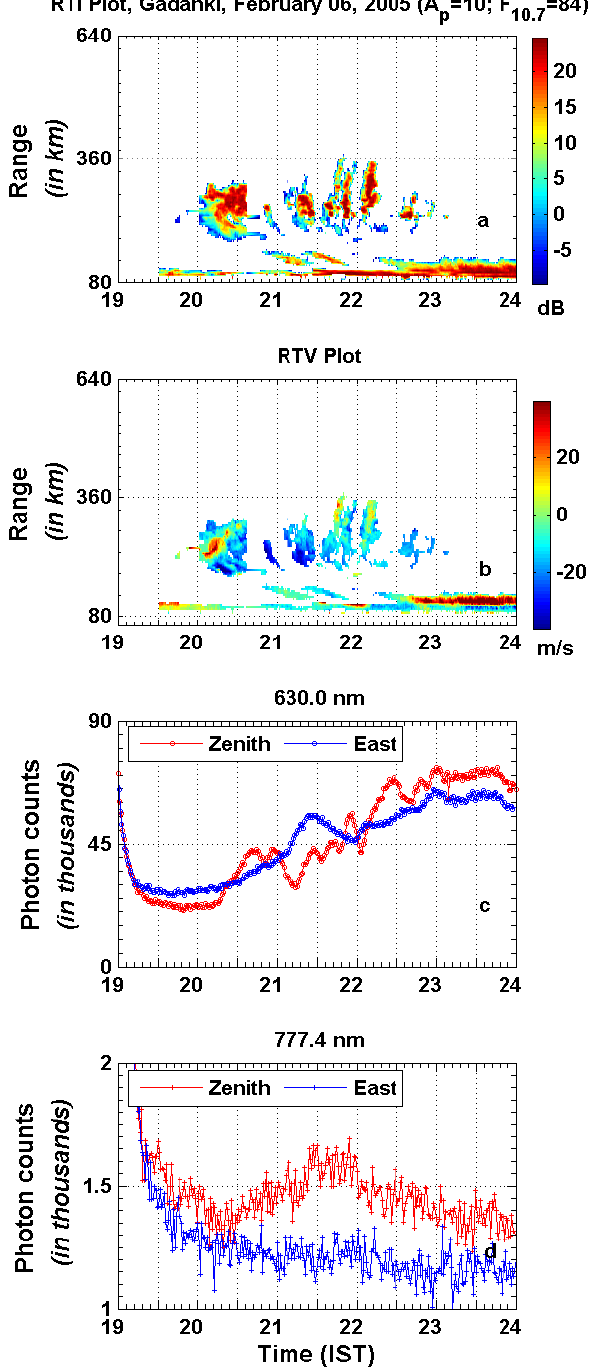
Fig. 9. Similar to Fig. 8 but for 6 February 2005 revealing closely- spaced multiple plume